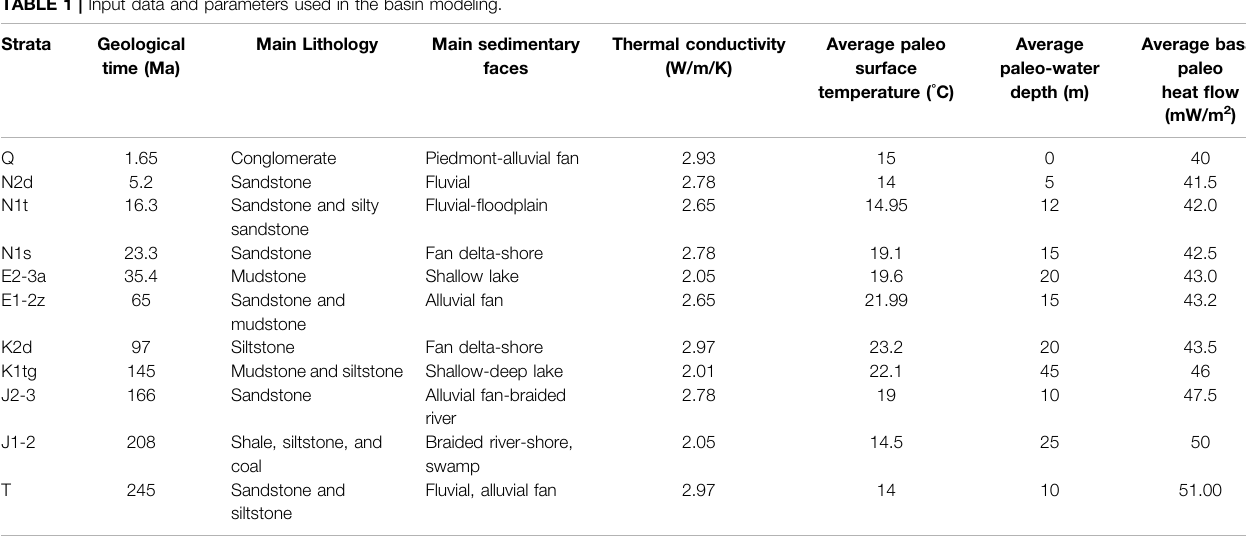
TABLE 1 | Input data and parameters used in the basin modeling. Strata Geological time